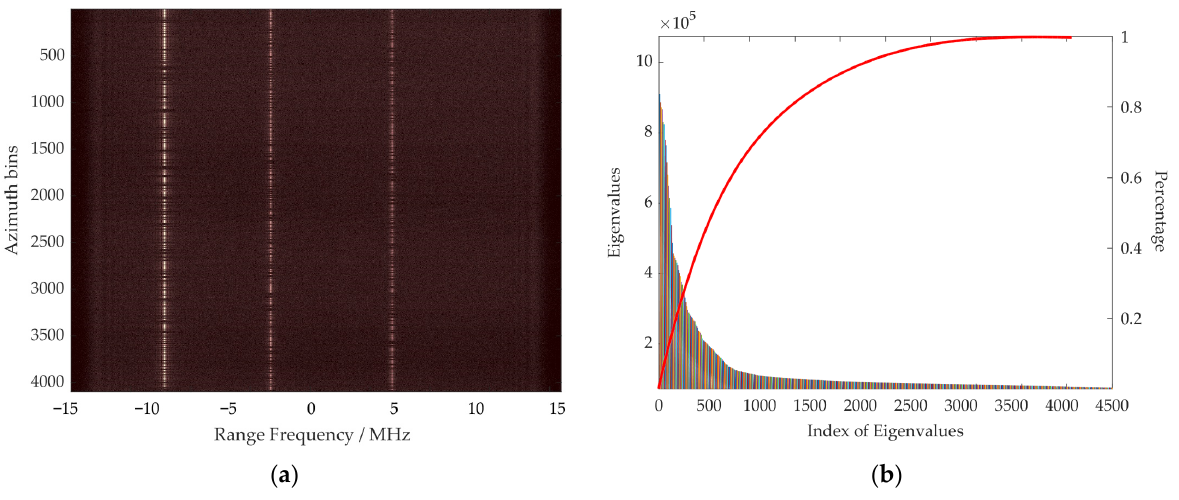
Figure 2. Structural analysis of RFI in range frequency domain: ( a ) spectrogram of SAR echoes con- taminated by RFI; ( b ) Eigenvalue sequences and analysis corresponding to ( a ). contaminated by RFI; ( b ) Eigenvalue sequences and analysis corresponding to ( a